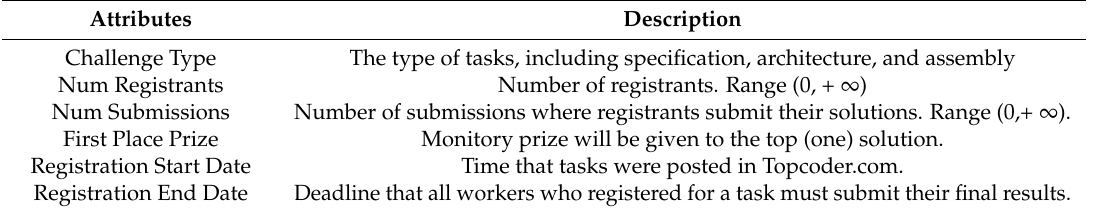
Table 3. The dataset of pass challenges’ attributes and descriptions.